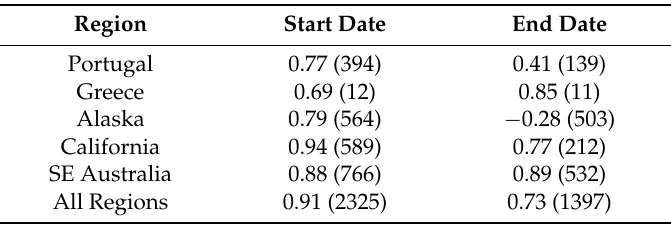
Table 3. Region-by-region Model Efficiency Index (MEF) and sample size (between brackets) for fire start and end dates.